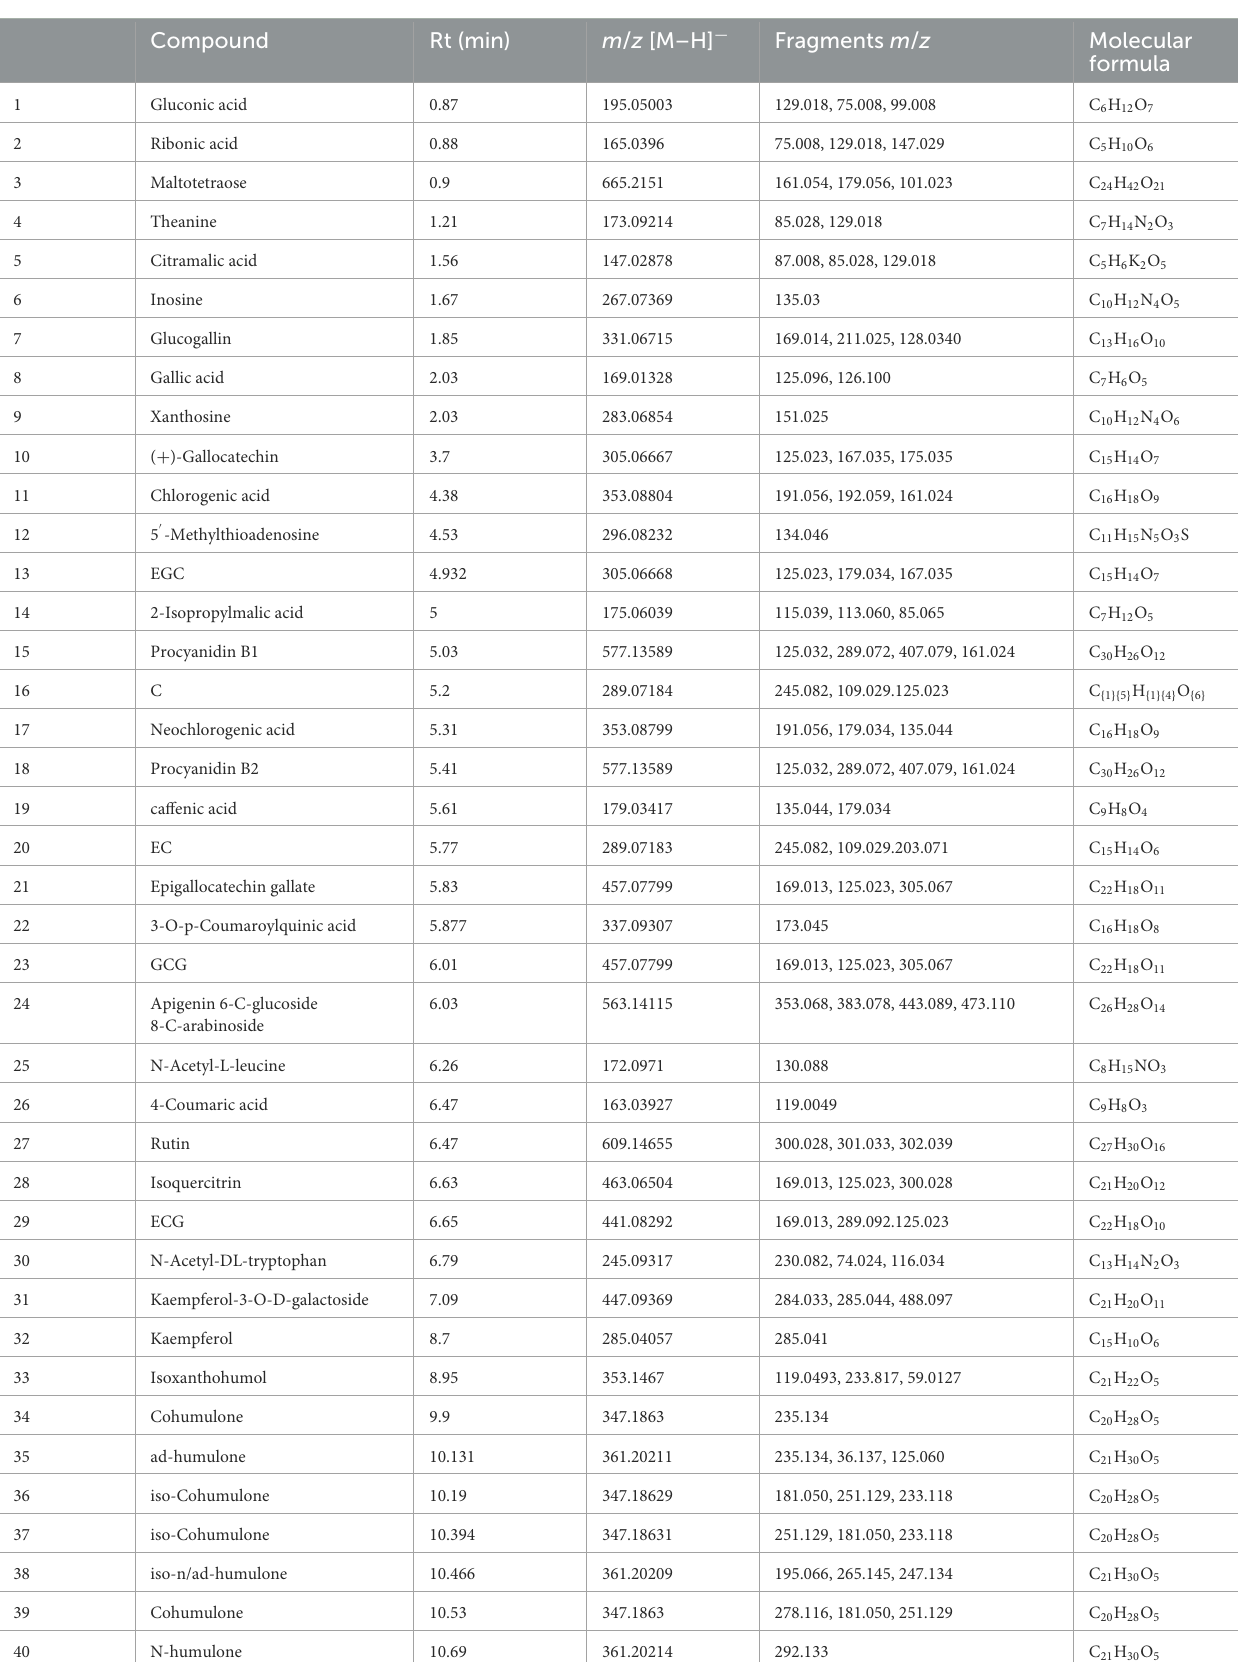
TABLE 4 Forty tentatively identified metabolites between two groups of beer sample (in negative